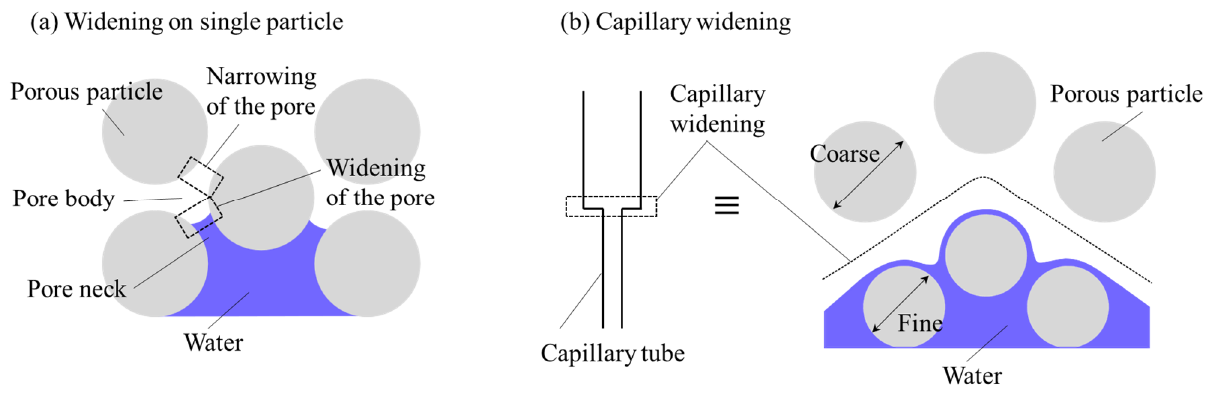
Figure 1. Two types of “interruption on widening void space” under microgravity: ( a ) the interrup- tion on the widening on the single porous particle [9] and ( b ) the interruption on the widening of capillary (Maruo et al. [10] for capillary tubes; Or et al. [11] for porous media).